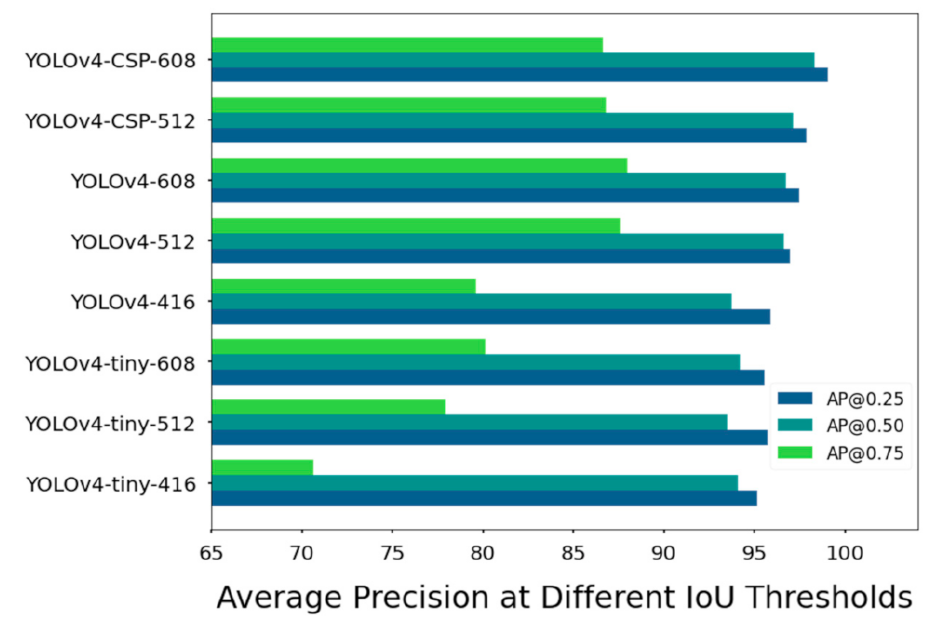
Figure 16. Average Precision (AP) of the YOLOv4 models at 25, 50 and 75% Intersection-over-Union (IoU) thresholds for the test set. The specific values are in Table A3.